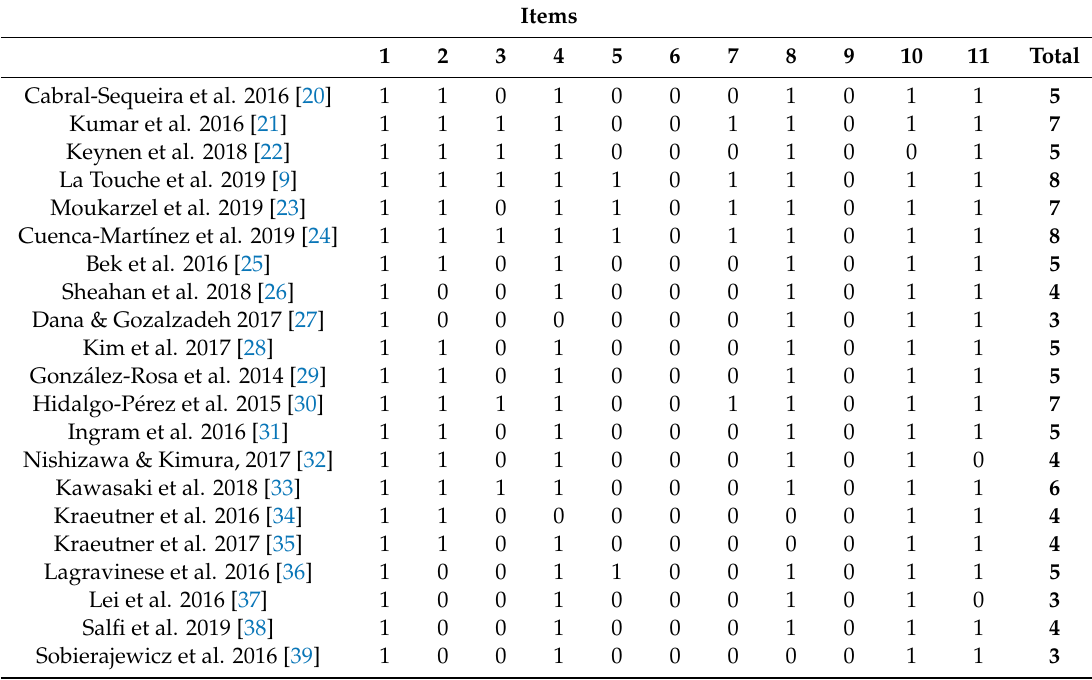
Table 2. Assessment of the studies quality based on the PEDro